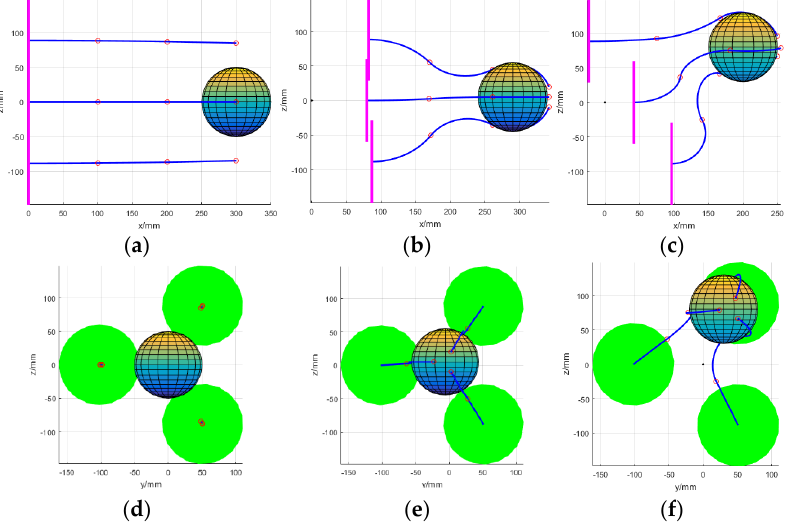
Figure 14. The process of grasping a ball using the multi-arm space robot. ( a ) Front view of initial state, ( b ) front view of middle state, ( c ) front view of final state, ( d ) lateral view of initial state, ( e ) lateral view of middle state, ( f ) lateral view of final state.